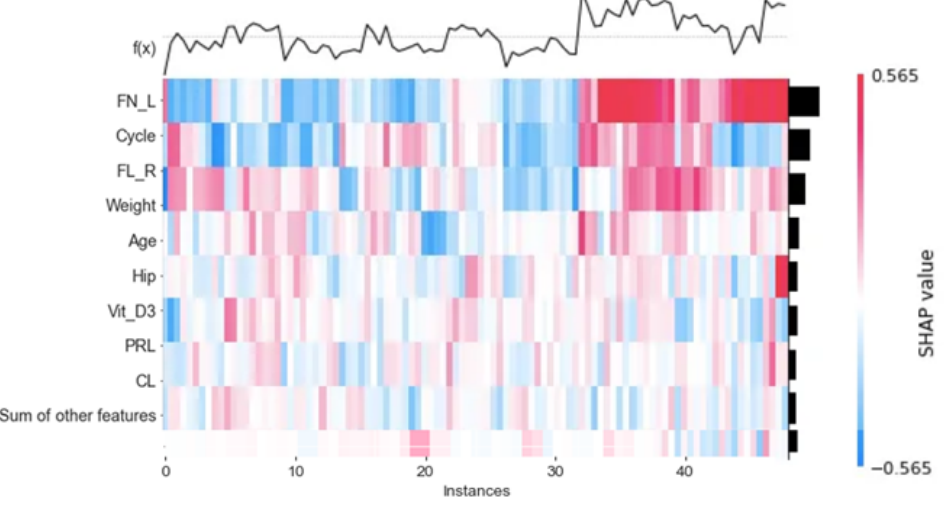
Figure 11. Heatmap of the developed